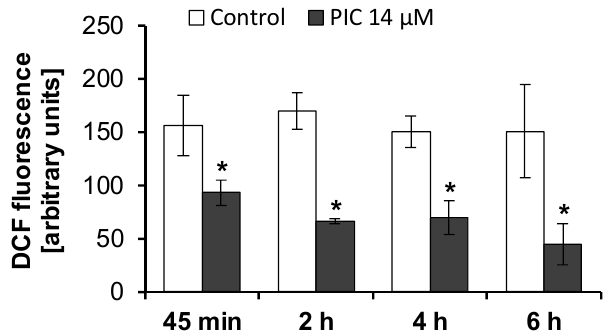
Figure 3. Effect of piceatannol on ROS production in HL-60 cells. Cells were incubated with piceatannol (IC 90 = 14 µM) for 45 min and 2, 4, or 6 h. Data are presented as means ± SD of three independent experiments in duplicates. * p < 0.05, statistically significant differences compared to control (Mann–Whitney U test).